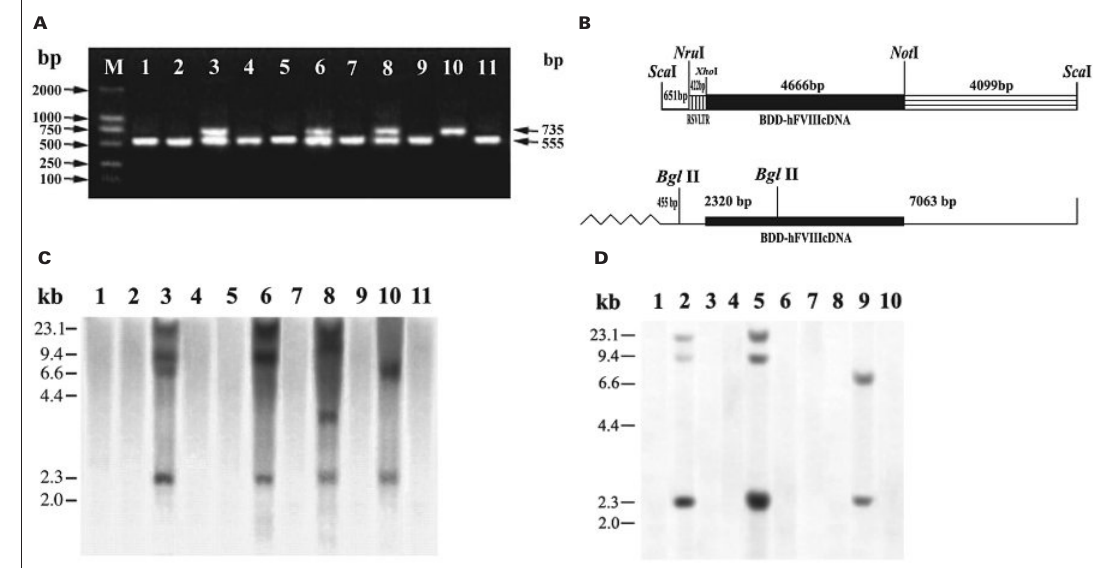
Identification for BDD-hFVIIIcDNA transgenic mice by PCR and Southern blotting. A PCR of the tail DNA from F0 progeny. A 735-bp specific fragment of BDD- hFVIII cDNA was amplified from the tail DNA of samples3, 6 and 8 F0 prog- eny respectively (lane 3, 6 and 8), and no fragment of BDD- hFVIII cDNA was amplified from the tail DNA of samples1, 2, 4, 5, 7 and 9 F0 progeny (lane 1, 2, 4, 5, 7 and 9). Lane M was DL2000 DNA Marker. Lane 10 showed a 735-bp fragment was amplified from Sca I linearized RC/RSV-BDD- hFVIII cDNA plas- mid, which served as positive control. Lane 11 were PCR products from the tail DNA of a normal C57BL/6 mouse, no fragment of BDD- hFVIII cDNA was amplified either. A 555-bp fragment of mouse GAPDH gene (inner control) was amplified from the tail DNA of all mice. B Map of the RC/RSV-BDD- hFVIII cDNA construct. RC/RSV-BDD- hFVIII cDNA was 9838-bp long, including the BDD- hFVIII cDNA (4666-bp) and the LTR-RSV region (422-bp). Cloning sites were shown on the schema.The construct was linearized with Sca I. Bgl II digestion of RC/RSV-BDD- hFVIII cDNA yielded three bands, 455-bp, 2320-bp and 7063-bp. C Southern blotting of the tail DNA from samples 1 to 9 F0 progeny (lane 1–9), DNA from control mouse plus Sca I linearized RC/RSV-BDD- hFVIII cDNA (lane 10) and DNA from a normal control C57BL/6 mouse (lane 11).The tail DNA was digested with Bgl II, run on 0.8% (w/v) agarose gel, and blotted and probed with the BDD- hFVIII cDNA minigene.The two bands of 2320-bp and 7063-bp generated by Bgl II were in lane 10. After Bgl II digestion of the trans- genic mouse genomic DNA, the following pattern could be predicted to occur: ( i ) 1 integration site, 1 copy: an internal 2320-bp band and one band of >7063-bp; ( ii ) 1 integration site, 2 copies, head-to-tail orientation: two copies of the 2320-bp band plus one 7518-bp band and one band of >7063-bp; ( iii ) 1 integration site, 2 copies, head-to-head orientation: two copies of the 2320-bp band and two bands of >7063-bp; ( iv ) 1 integration site, 2 copies, tail- to-tail orientation: two copies of the 2320-bp band and one 14126-bp band; ( v ) more than one integration site, 1 copy in each: multiple copies of the 2320-bp band and multiple bands of >7063-bp of different sizes. Combinations of the above cases were also possible. A further degree of complexity could result from rearrangements of DNA after integration. Lane 3 showed bands of >20, 9.0, 7.5 and 2.3 kb, pattern was compatible with array ( ii ) or with a combination of patterns ( i ) and ( ii ) or ( ii ) and ( v ). Lane6 showed bands of >20, 9.0 and 2.3 kb, pattern was compatible with array ( iii ) or with a combination of patterns ( i ) and ( iii ) or ( iii ) and ( v ). Lane 8 showed bandsof >20, 14, 4.1 and 2.3 kb, pattern was compatible with array ( iv ) or with